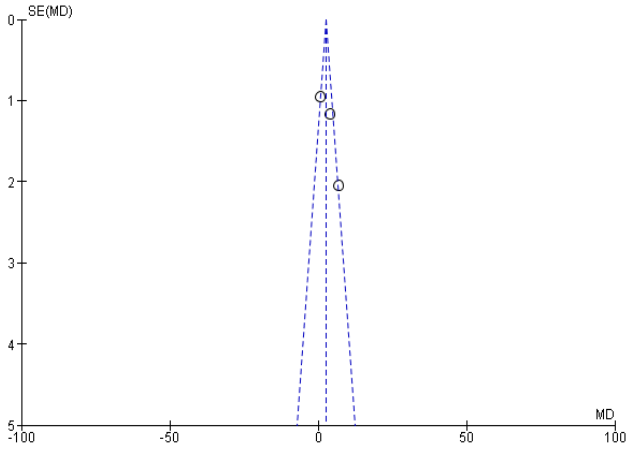
Figure 9. Funnel plot for functional appliance between experiment and control.